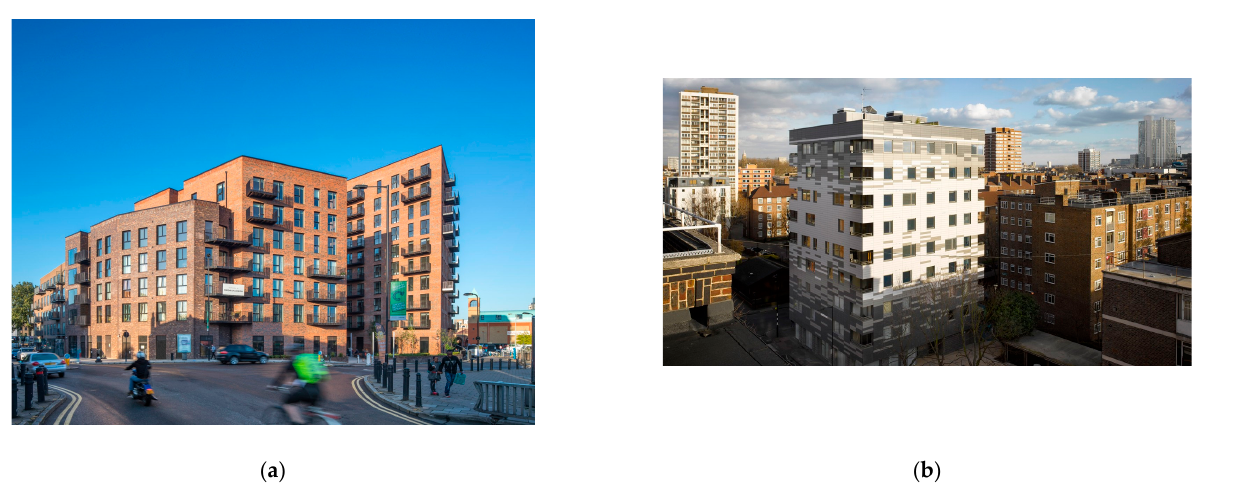
Figure 1. Examples of multi-storey CLT residential buildings: ( a ) Dalston Works, London (Photo: Daniel Shearing) [7]; ( b ) Murray Grove, London [8].